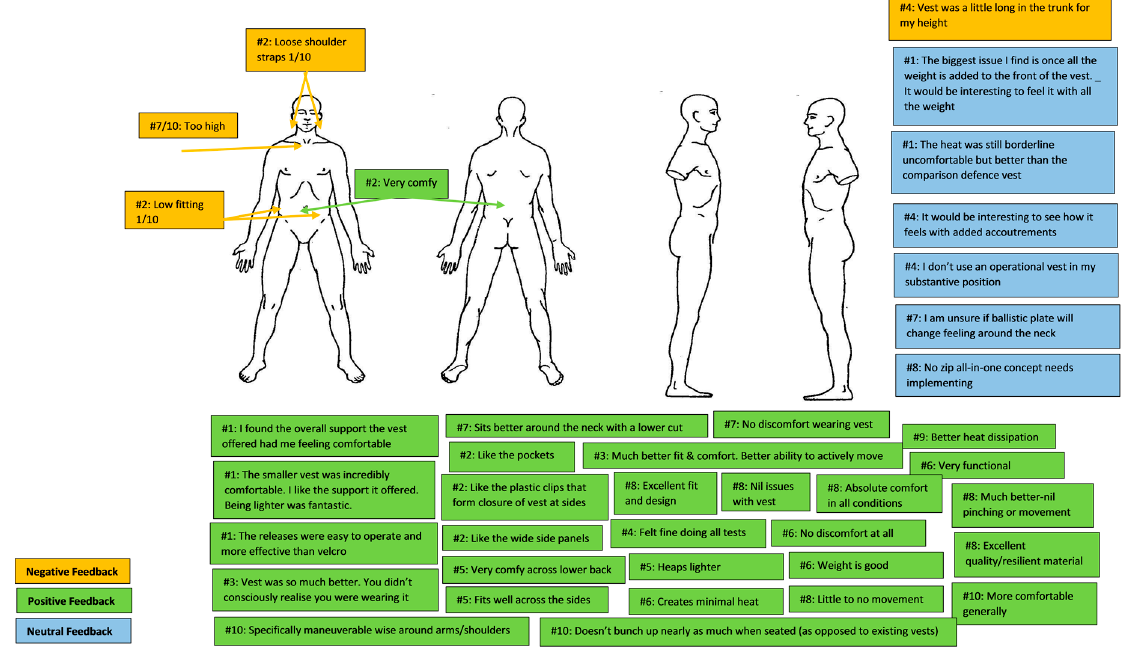
Figure 4. Subjective feedback on law enforcement body armour (# signifies participant number; scores out of 10 signify discomfort level).